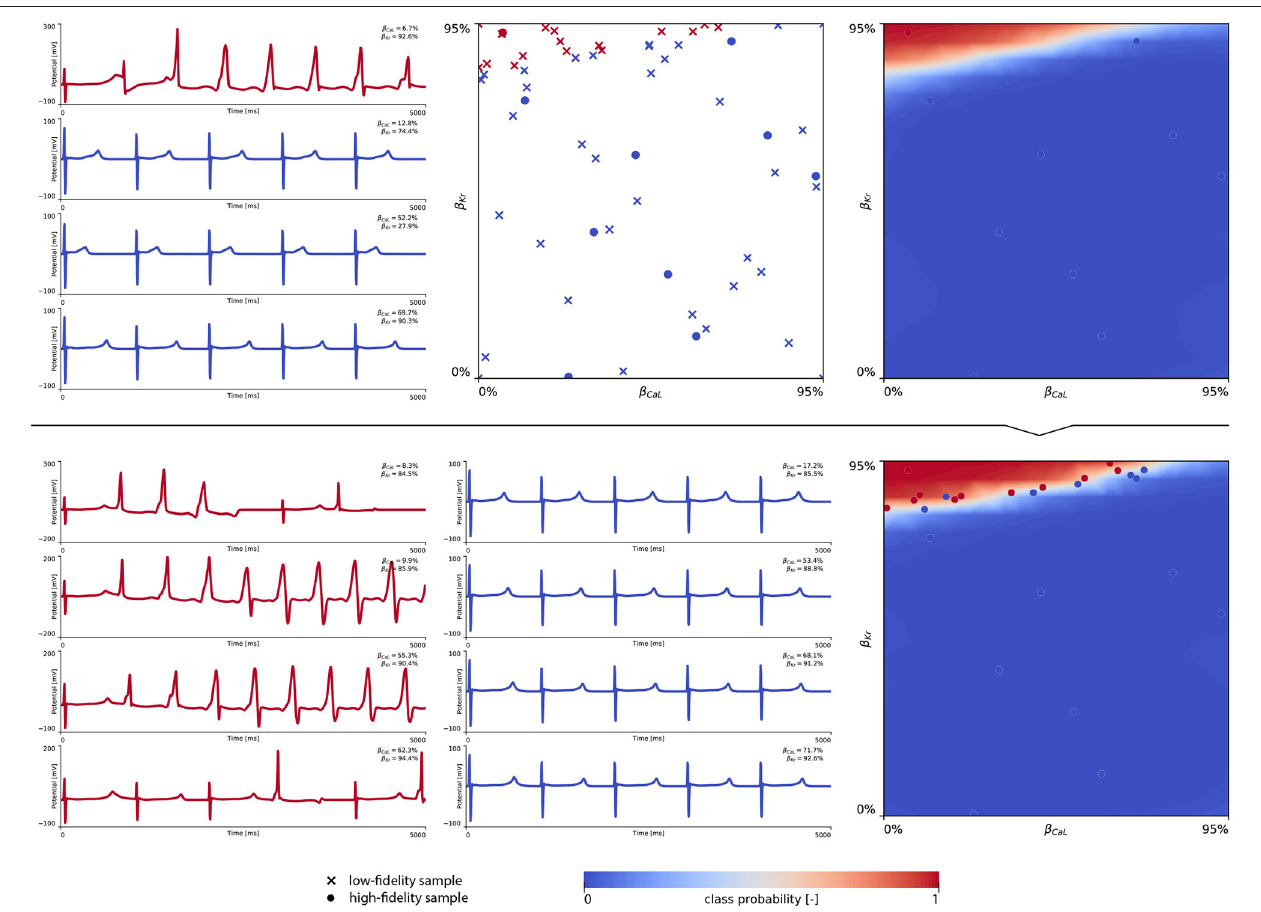
FIGURE 7 | Male multi-fidelity drug-induced arrhythmogenic risk classifier . (Upper) Initial exploration of the male drug-induced arrhythmogenic risk parameter space. The first 10 internal Latin hypercube samples of the B = { β Kr , β CaL } parameter space were evaluated for male drug-induced arrhythmogenicity, as showcased in the upper middle plot with “dot” markers. Here, the low-fidelity samples from training the low-fidelity male midwall Gaussian process classifier are shown with “x” markers. Virtual electrocardiograms of one arrhythmic and three normal { β Kr , β CaL } samples are shown in the upper left column plots. The resulting drug-induced arrhythmogenicity probabilities for the male heart is shown in the upper right plot. (Lower) Active learning exploration and exploitation of the male drug-induced arrhythmogenic risk classification boundary. The multi-fidelity Gaussian process classifier was trained further using 15 additional active learning high-evaluations of { β Kr , β CaL } effects. On the lower left, four additional arrhythmic sample evaluations are shown. The lower panel middle plot showcases four additional sample evaluations showcasing normal heartbeats. The final male multi-fidelity drug-induced arrhythmogenicity classification boundary is shown in the lower right